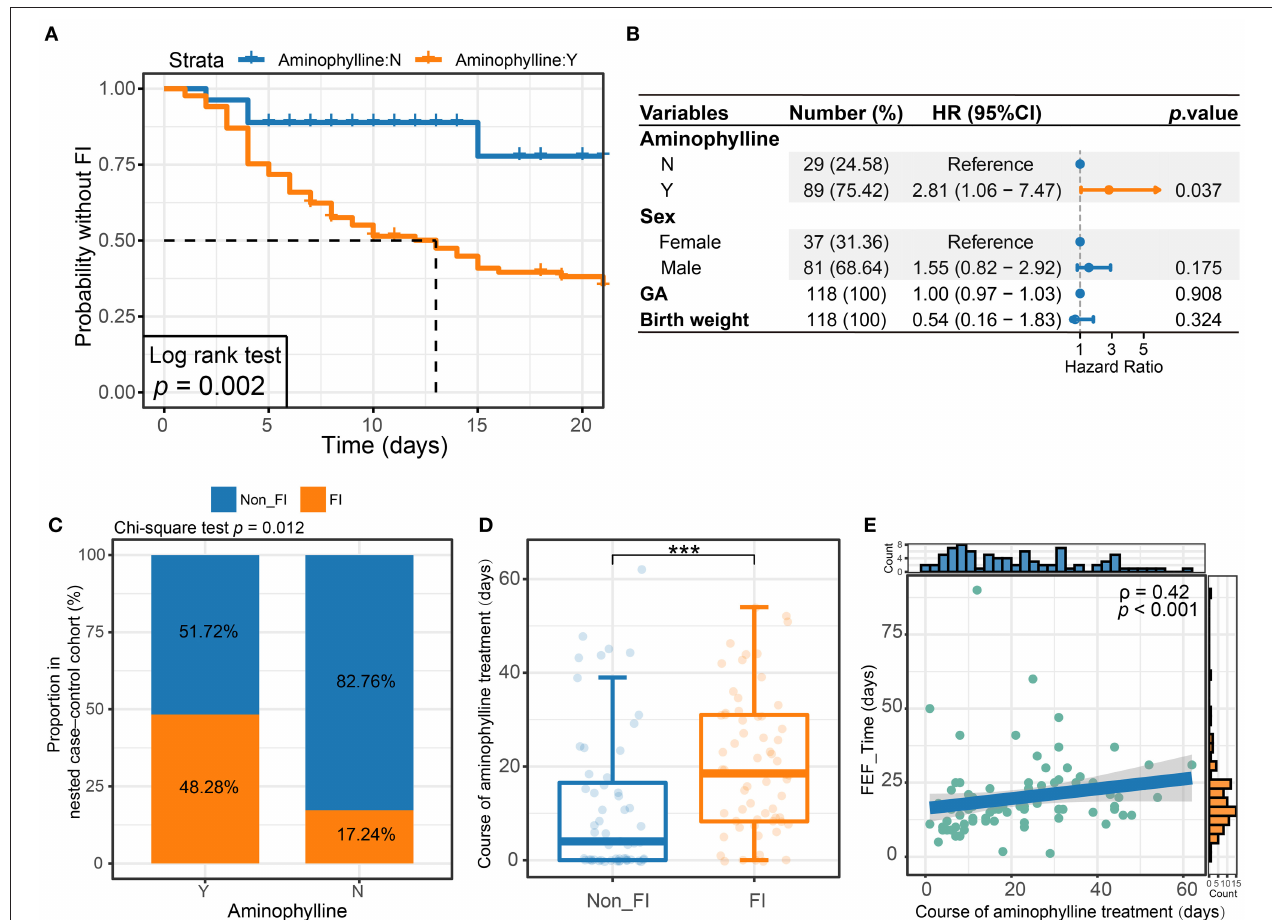
FIGURE 2 | The relationship between aminophylline treatment and FI events. (A) Kaplan–Meier survival analysis of FI between groups treated with aminophylline. The group treated with aminophylline had a higher FI risk (log rank P = 0.002). (B) Forest plot showing the results of multivariate Cox regression analyses. The points and horizontal lines correspond to the adjusted hazard ratios and 95% confidence intervals. Orange indicates statistical significance ( P < 0.05). (C) Stacked bar plot showing that the proportions of FI were different between groups treated with aminophylline in the aminophylline nested case-control cohort. (D) Boxplot showing the course of aminophylline in patients with FI and without FI. ***, P < 0.001. (E) Scatter plot showing the correlation between time to full enteral feeding (FEF_Time) and the course of aminophylline in patients taking aminophylline. The histograms above and on the right show the distribution of the course of aminophylline and FEF_Time, respectively. Spearman correlation coefficients ( ρ values) and P -values are shown in the top left